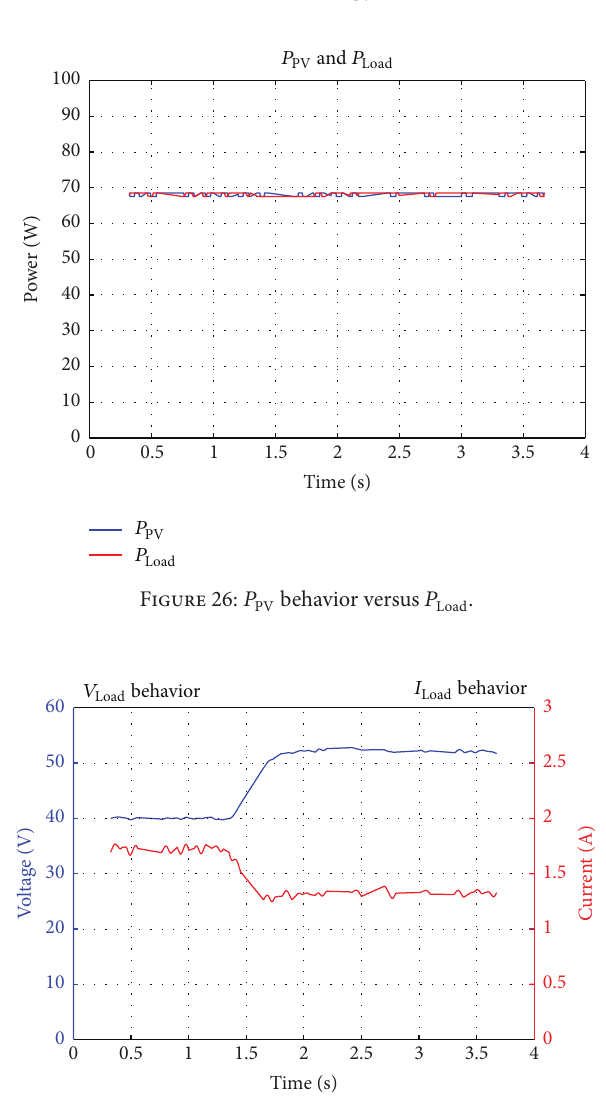
the same that the MPP provided the P-I characteristic curve as shown in Figure